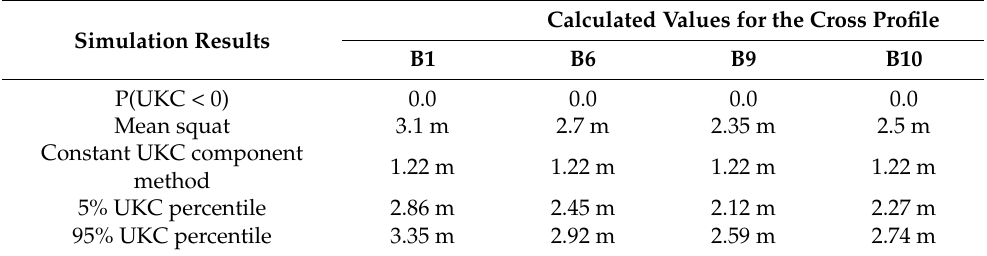
Table 6. Results of UKC probabilistic model for the analysed bridges’ cross-sections on Vistula’s waterways.